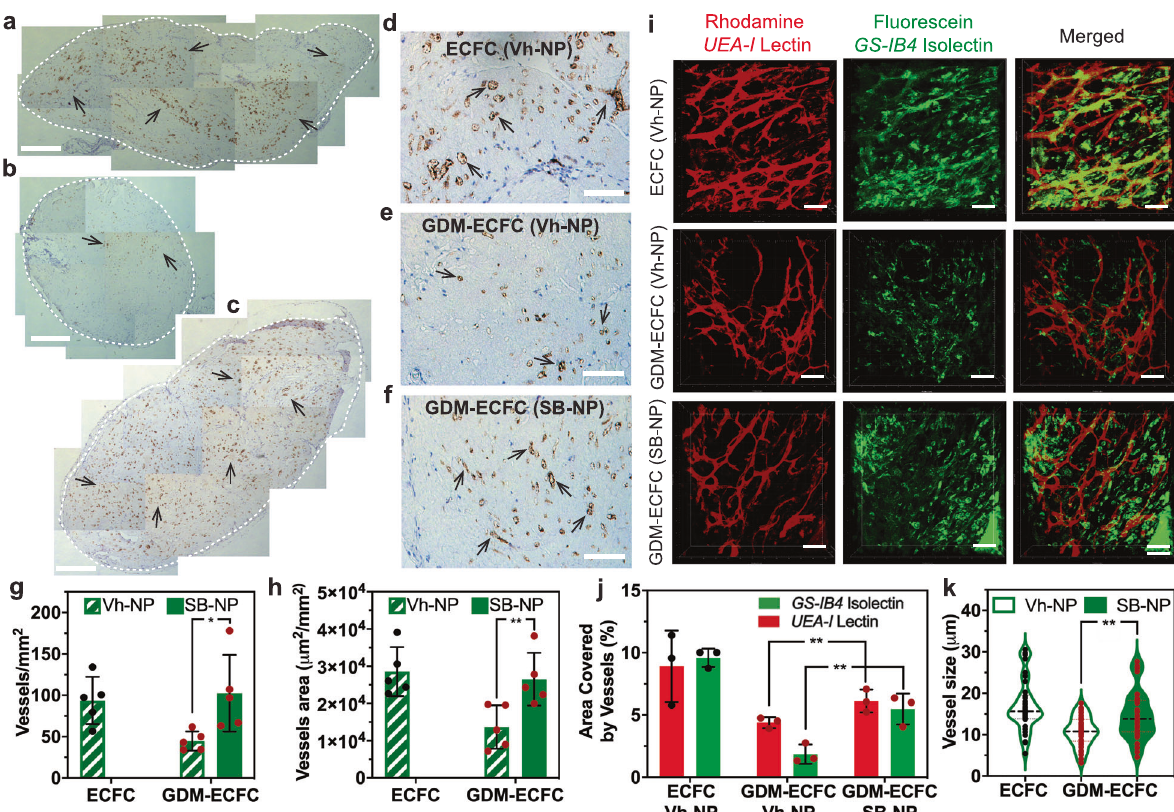
Fig. 6 In vivo functionality of ECFCs conjugated with bioactive nanoparticles. Normal and GDM-ECFCs were conjugated with nanoparticles containing either vehicle (Vh) or 40 µ M SB-431542 (SB). Conjugated ECFCs (100,000 cells/gel) were encapsulated in collagen/ fi bronectin gels for 48 hr to form vascularized networks and then transplanted into the side fl anks of NOD/SCID mice ( n = 4-6 animals/group). Representative IHC images stained with anti-human CD31 illustrate the graft harvested 14 days following transplantation (highlighted in white dotted circle) for ( a ) ECFCs (Vh-NP), ( b ) GDM- ECFCs (Vh-NP), and ( c ) GDM-ECFCs (SB-NP). Scale bars are 500 µ m. Representative high magni fi cation IHC images of grafts from ( d ) ECFCs (Vh-NP), e GDM-ECFCs (Vh-NP), and ( f ) GDM-ECFCs (SB-NP) after 14 days implantation into NOD/SCID mice stained with anti-human CD31 (brown). Arrows indicate human CD31 + vessels, which are perfused with murine erythrocytes. Scale bars are 30 µ m. The number and size of human CD31 + vessels were quanti fi ed and plotted. Compared to the Vh-NPs control, SB-NPs conjugation increases ( g ) vessel density (* P = 0.011) and ( h ) vessel area (** P = 0.0058) formed by GDM-ECFCs in vivo. Five animals ( n = 5; mean ± s.d.) were used to evaluate each group: normal ECFCs ( black data dots) and GDM-ECFCs ( red data dots). i Representative intravital images of grafts pre-perfused with rhodamine-conjugated UEA-I lectin to stain the human vessels (in red) and fl uorescein-conjugated GS-IB4 to stain the mouse vessels (in green). 3D confocal rendering demonstrated the interaction between human vasculature (in red) and mouse vasculature (in green) for normal ECFC, GDM-ECFCs conjugated with Vh-NPs and GDM-ECFCs conjugated with SB-NPs. Scale bars are 40 µ m. j Vessel quanti fi cation and analysis reveal the percent area covered by human vasculature ( UEA-I lectin) and mouse vasculature ( GS-IB4 isolectin). SB-NPs conjugation to GDM-ECFCs results in the signi fi cant increase of both human vessels (** P = 0.021) and mouse vessels (** P = 0.006) that were interconnected to each other. Three animals ( n = 3; mean ± s.d.) were used to evaluate each group: normal ECFCs ( black data dots) and GDM-ECFCs ( red data dots). k Vessel quanti fi cation reveals the size distribution of the vessels found in the explant for normal ECFCs, GDM-ECFCs conjugated with Vh-NPs and GDM-ECFCs conjugated with SB-NPs. Compared to the Vh-NPs control, SB-NPs conjugation results in an increase in the mean of vessel size distribution from for GDM-ECFCs (** P =